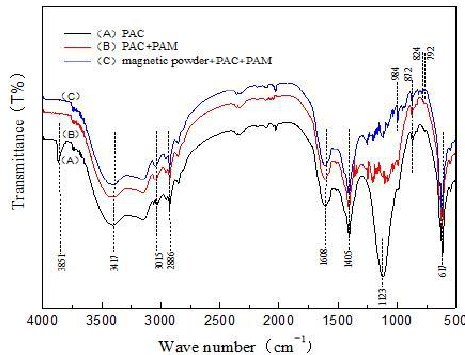
Figure 7. FTIR of flocs treated by three methods.